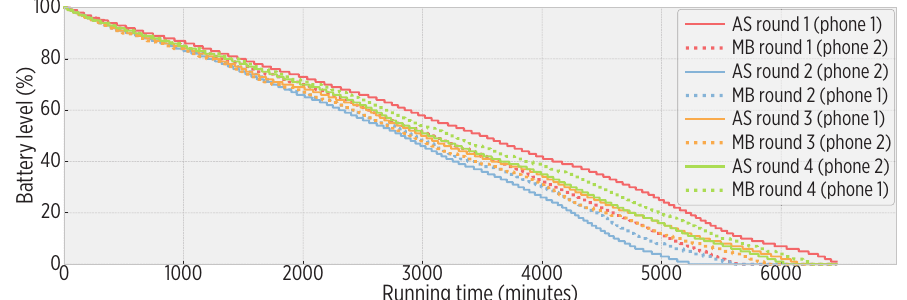
Figure 9. Energy overhead (seen as battery burnout) of the map builder with respect to an agnostic sampling rate. (AS = Agnostic Sampling system, MB = Map Builder system). In overall, the MB achieved 98% of AS running time, causing a small impact on